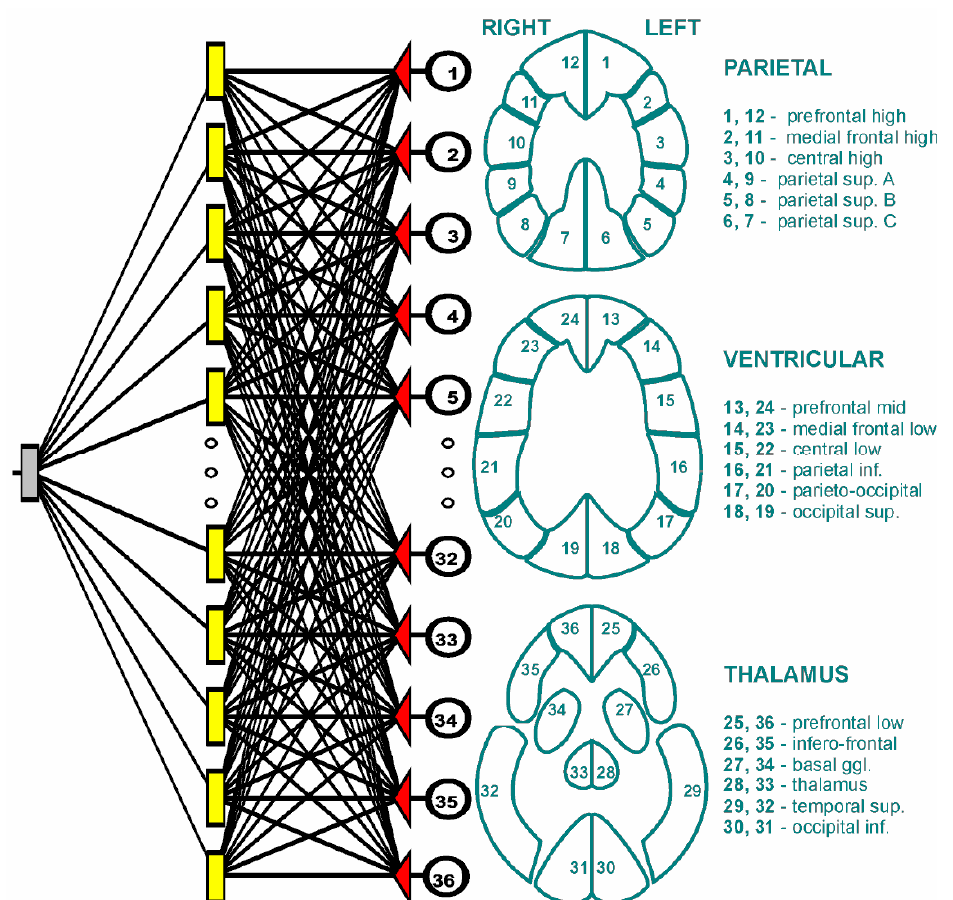
Figure 1. On the left panel is shown the architecture of the artificial neural network. On the right panel are presented the brain profiles that each contain 12 areas.